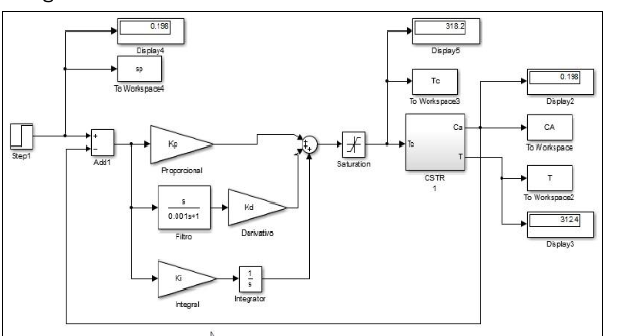
Figura 10: Diseño en Matlab/Simulink del controlador PID para Reactor Químico CSTR. Fuente: Los Autores, (2018).